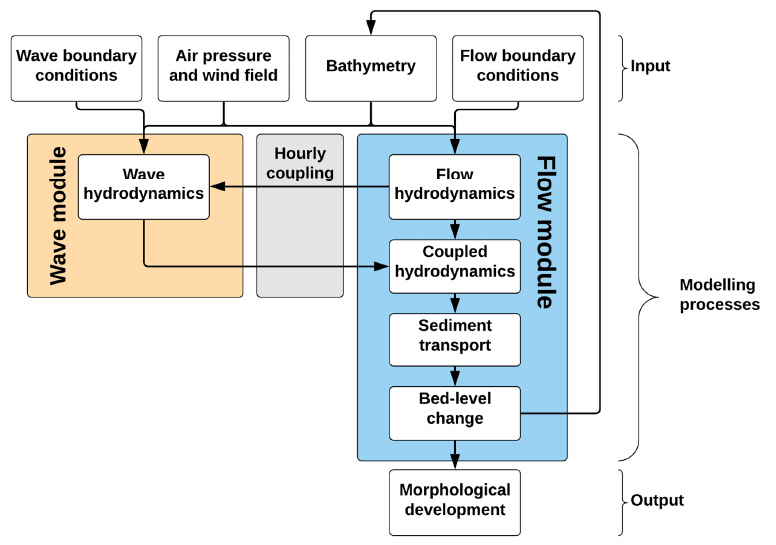
Figure 4. Schematization of processes introduced in Sections 2.2 and 2.3 and how these processes interact with each other in Delft3D Flexible Mesh. Arrows indicate the flow of data. The computational time step within the wave module is hourly. For the flow module, this is equal to the numerical time step. Arrows through the ‘hourly coupling’ section indicate the communication of data between the modules, which is performed